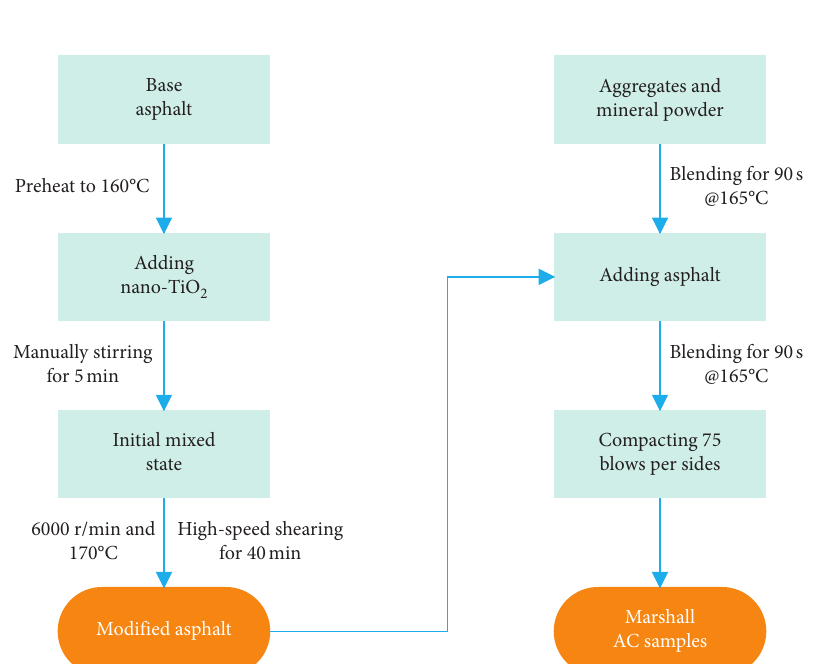
Figure 2: Sample preparation